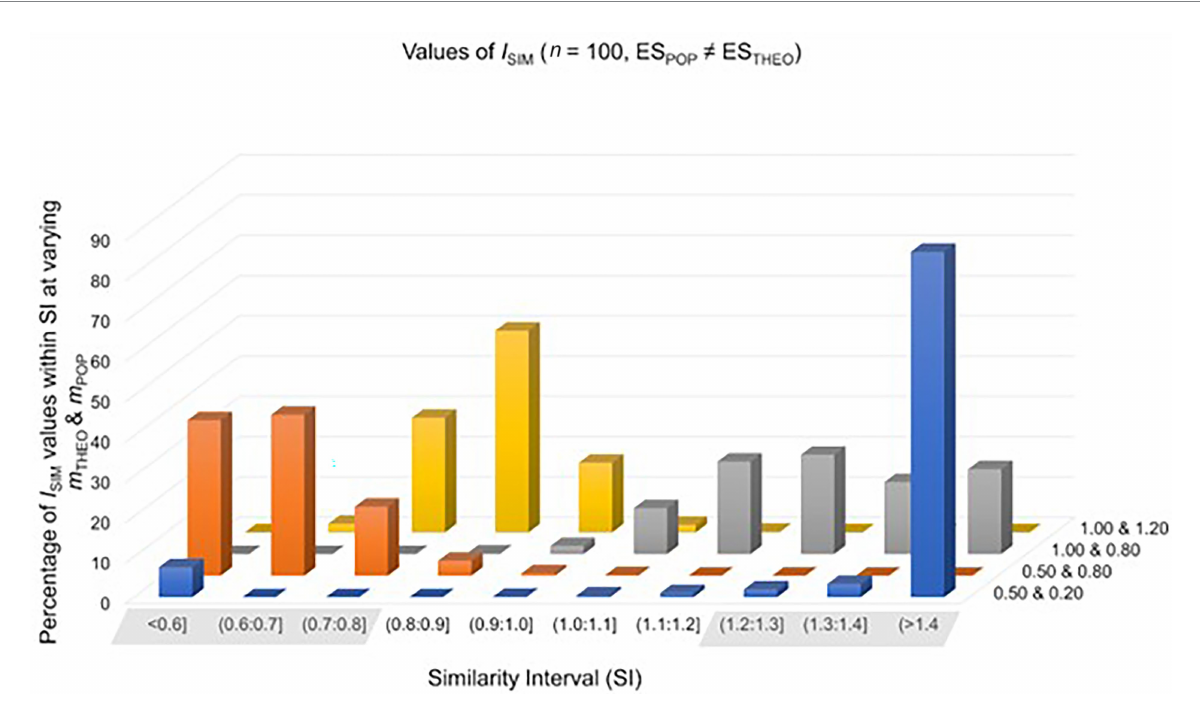
FIGURE 2 Values of I SIM were calculated in 10,000 simulated study-settings with n 0 = n 1 = 100 under the assumption that the theoretically predicted effect does not match the population effect. Each row of this graph represents different combinations of m THEO and m POP